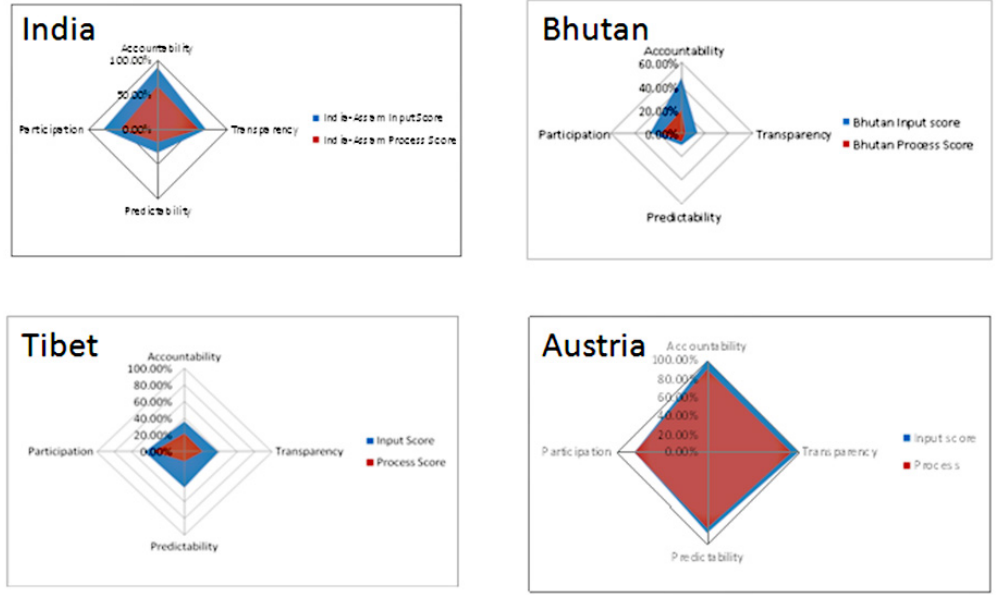
Figure 11. Attributes of the water resources government framework for the study area authorities. Input refers to the current legal framework in place and output refers to